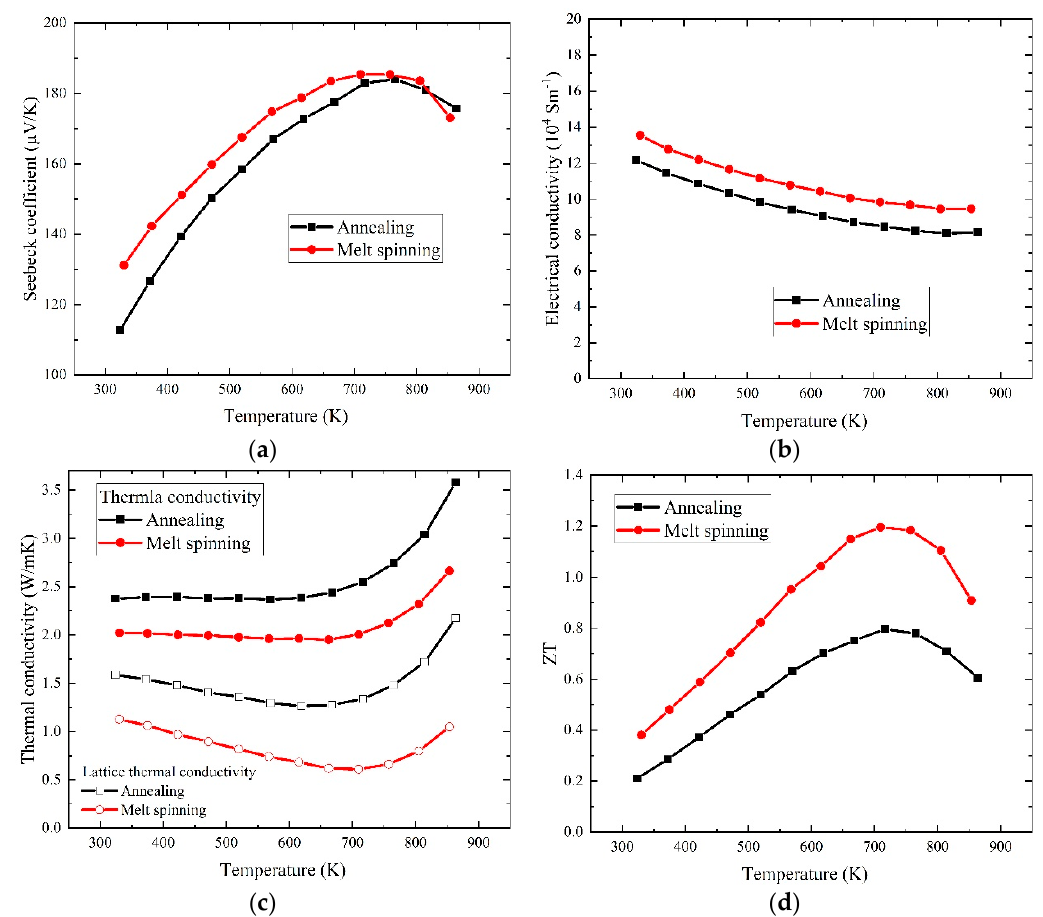
Figure 7. The temperature-dependent thermoelectric properties of the annealed and melt-spinning samples ( a ) the Seebeck coefficient, ( b ) the electrical conductivity, ( c ) the thermal conductivity and ( d ) the dimensionless figure of merit, ZT .